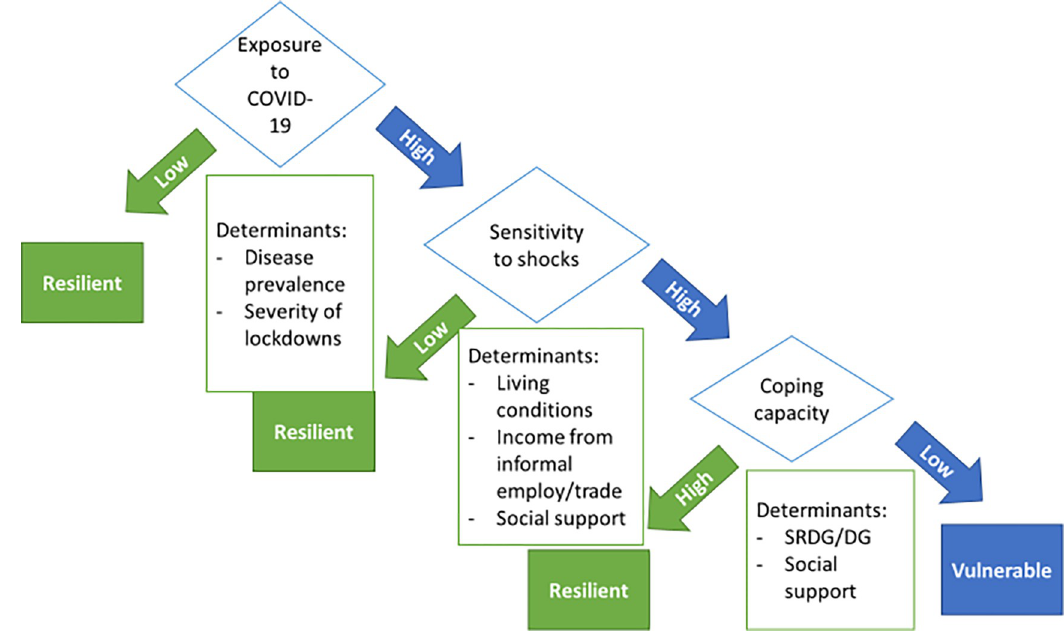
Fig 2. Determinants of vulnerability and resilience experienced by TB patients in the